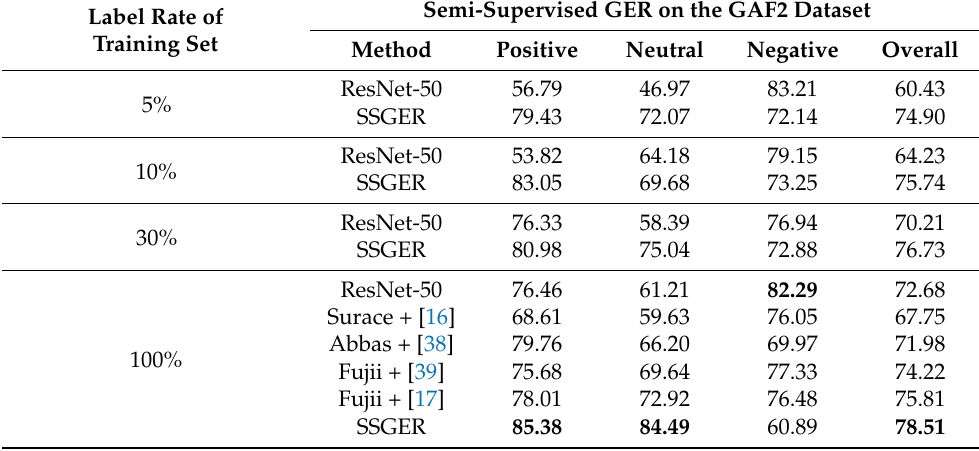
Table 2. Comparison of classification accuracy (in %) on the GAF2 dataset. The values in bold refer to the best